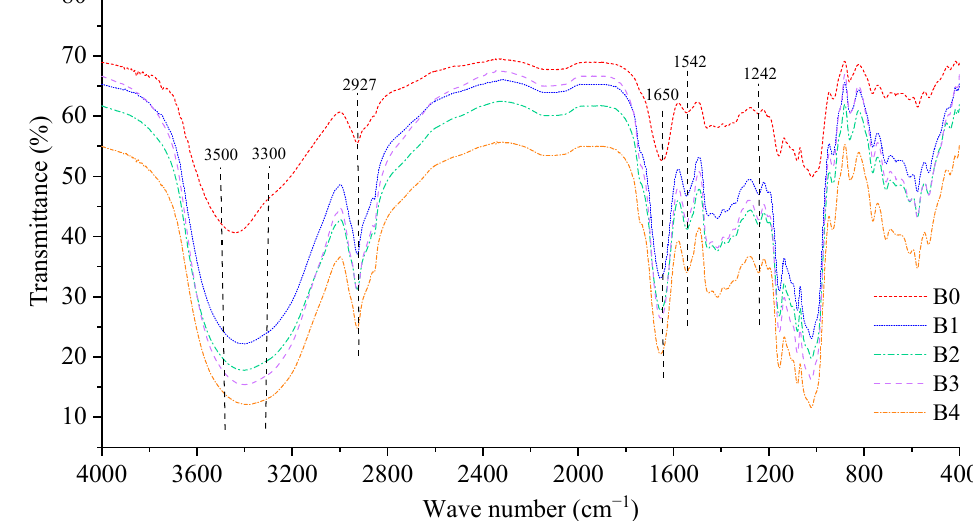
Figure 4. Infrared spectrum scan of the wheat bran. The B0, B1, B2, B3, and B4 are the wheat bran prepared under the rolling frequencies 0, 6, 9, 12, and 15